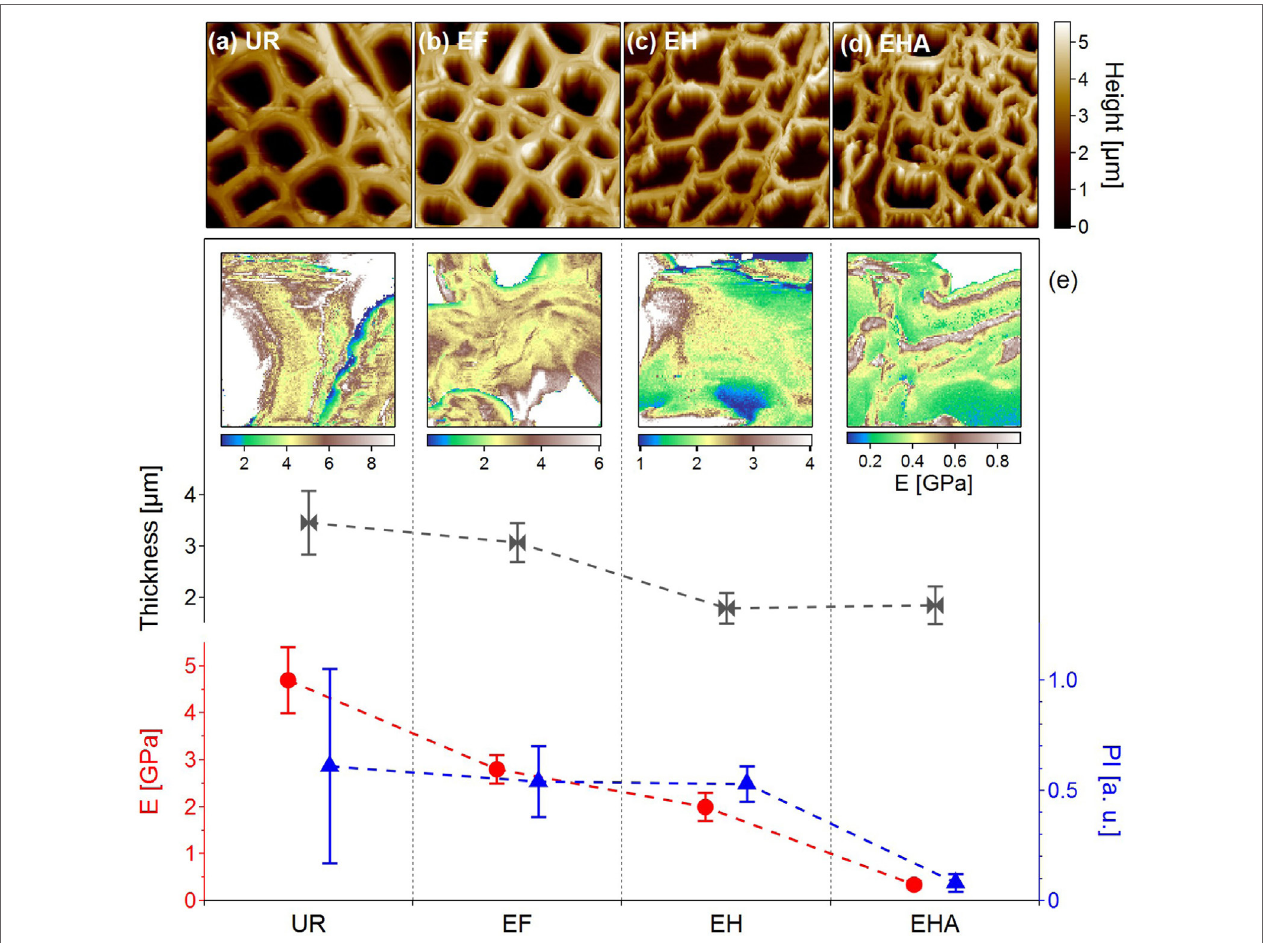
FiGURe 2 | Examination of poplar samples through the delignification process steps. (A–D) AM-AFM topographic images of untreated raw (UR), extractive-free (EF), holopulped (EH) and acid-treated (EHA) samples showing the structural changes along the delignification process (image size 50 × 50 µm 2 ). The average PCW thicknesses extracted from the topographic images are plotted in (e) (gray curve). (e) Images: Young’s modulus (GPa) mappings for each type of samples extracted from quantitative force–volume mappings. Image size is 5 µm × 5 µm. The corresponding average Young’s moduli values (E) are reported in red. Blue triangles: Average values of the plasticity index (PI) extracted from the quantitative force–volume mapping. Data from Farahi et al. (2017),